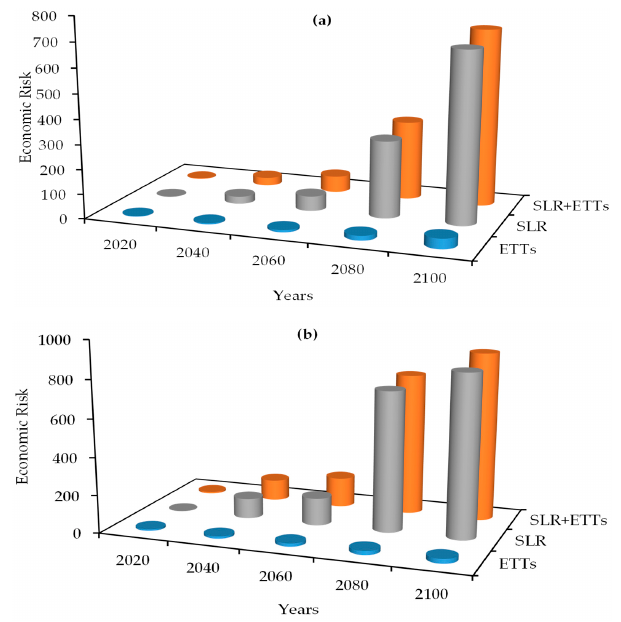
Figure 9. Projected economic risk values for ( a ) Fethiye City Center, Turkey and ( b ) the Cairo Agricultural Area, Egypt. Water 2020 , 12 , x FOR PEER REVIEW Social risks due to ETTs and SLR increase for all future years for Fethiye City Center and the Cairo Agricultural Area are shown in Figure 10a,b, respectively. A minor oscillation in social risk for Fethiye City Center can be observed due to a decrease in the projected PGR for 2080 and 2100, as shown in Figure 10a.